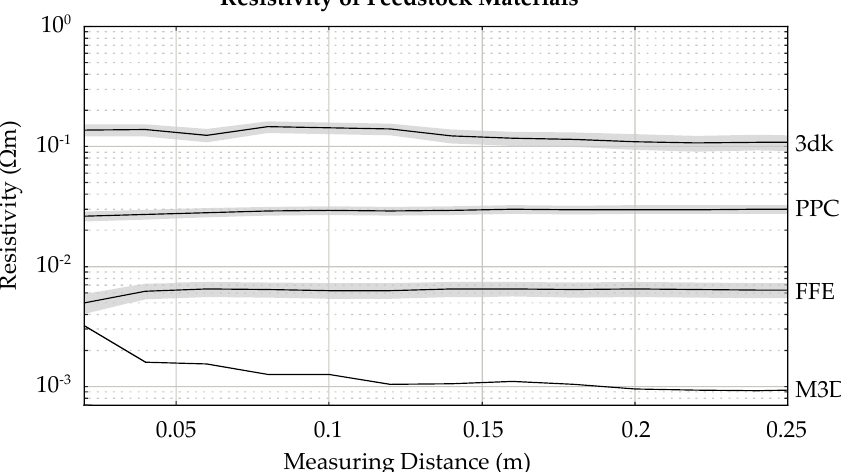
Figure 7. Influence of the silver paste on resistivity of the feedstock material.